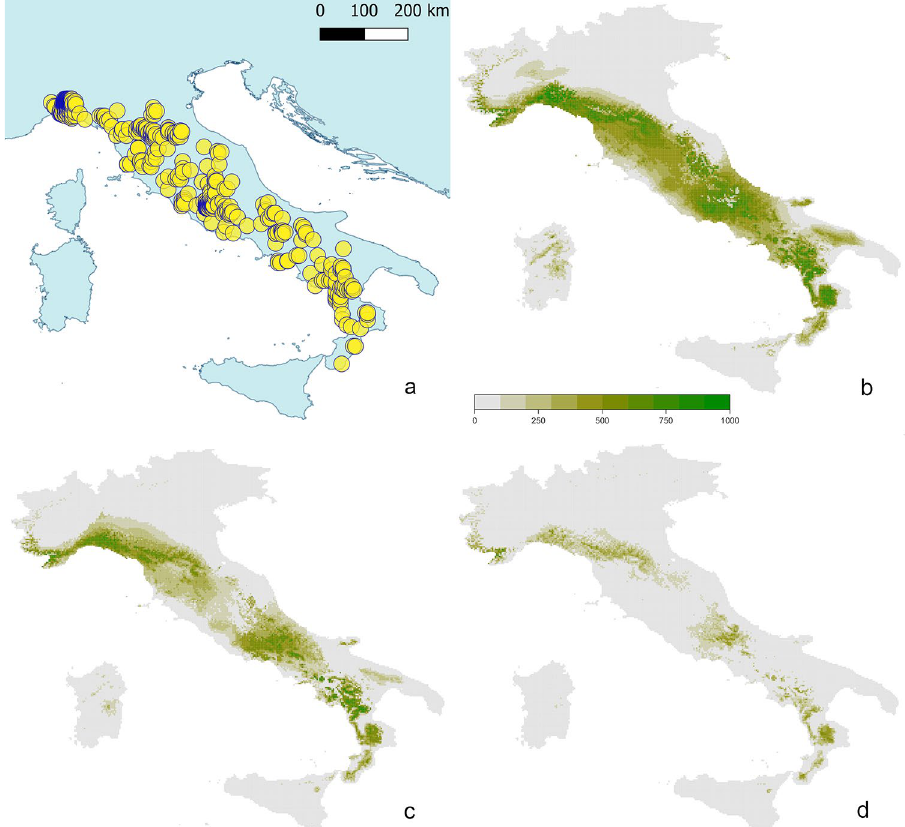
Figure 3. Extant distribution and future suitability projections for Salamandrina spp. in Italy. ( a ) Presence data of Salamandrina spp. used in this analysis defining the current range of the species; ( b ) Ecological Niche Modelling for Salamandrina in Italy using extant bioclimatic variables. ( c , d ) Future projections using the bioclimatic variables for 2070: c, RCP 2.6, very stringent pathway (1 °C mean global warming increase during 2046–2065); d, RCP 8.5, very relaxed pathway (2 °C mean global warming increase during 2046–2065). Progressively darker green indicates higher climatic suitability for Salamandrina in a scale between 0 and